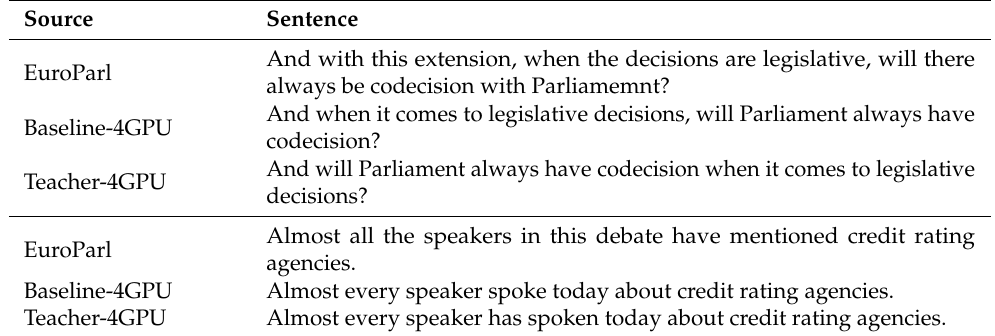
Table 8. Comparison of original English reference translations to MT outputs.